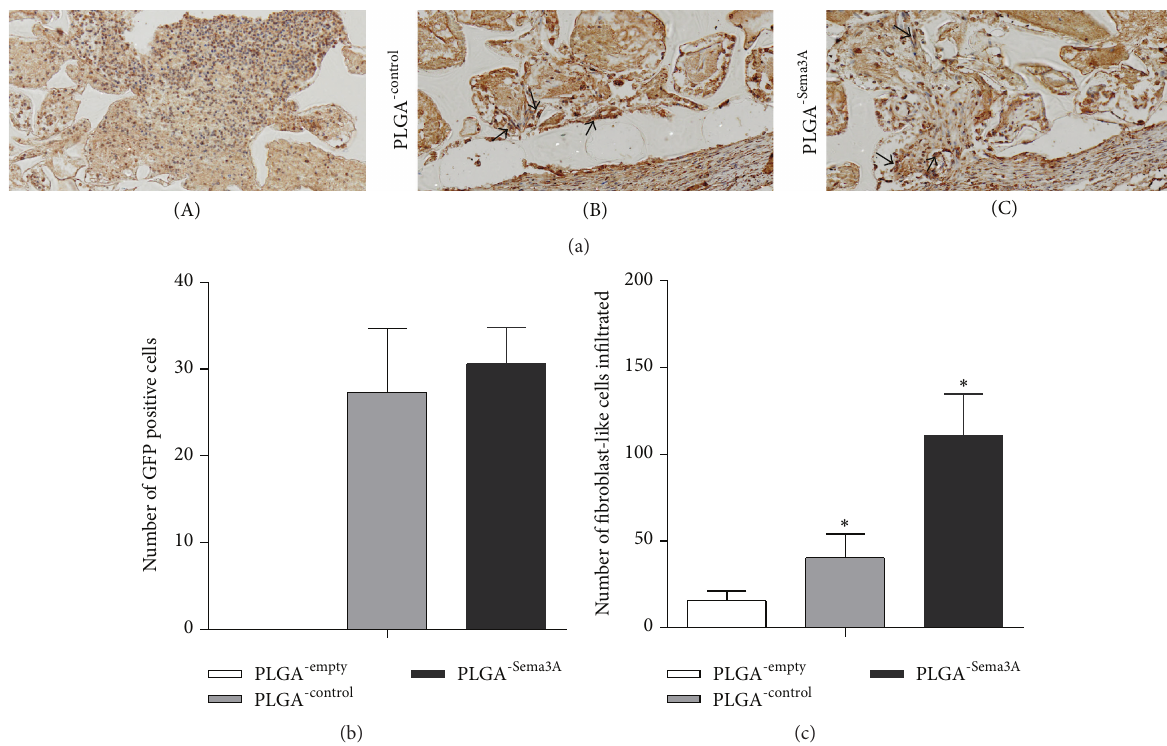
Figure 4: Sema3A infected ASCs decrease the immune cell infiltration while increasing fibroblast-like cells migrated to the implants. (a) The scaffolds were harvested 5 days after transplantation and immune-stained with collagen. (A) No GFP + fibroblast-like cells were found in the empty implants and multiple inflammatory cells were shown, (B) a small fraction of fibroblast-like cells were found in implants seeded with ASC - control , and (C) Multiple fibroblast-like cells were found migrated and migrating towards the scaffold in implants seeded with ASC - Sema 3 A . (b) Quantification data of survival GFP + ASCs in the scaffold. (c) Quantification data of migrated fibroblast-like cells. Mean ± SD, 𝑛 = 3 , and ∗ 𝑝 < 0.05